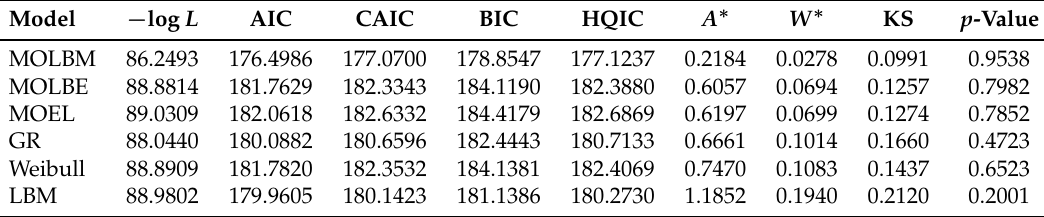
Table 8. Some criteria and goodness of fit measures for Data set 1.